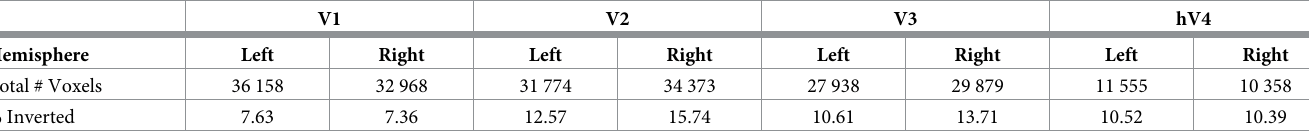
Table 3. Normalised percentages of inverted voxels in visual areas V1–V4, averaged across subjects.